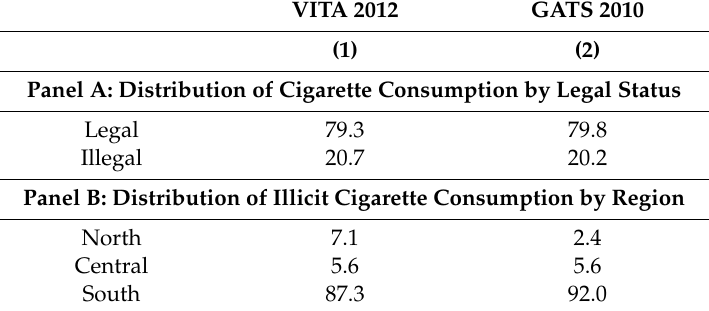
Table 1. Distribution of illicit cigarettes in Vietnam market (%).